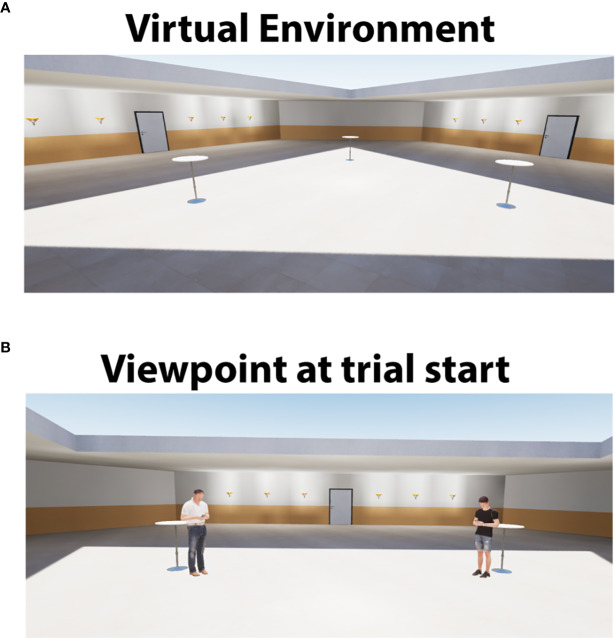
(A) Virtual Environment with no virtual agents present. (B) Virtual environment at the beginning of a trial with two agents in passive mode. Participants were equidistant from both agents (always 6 m).